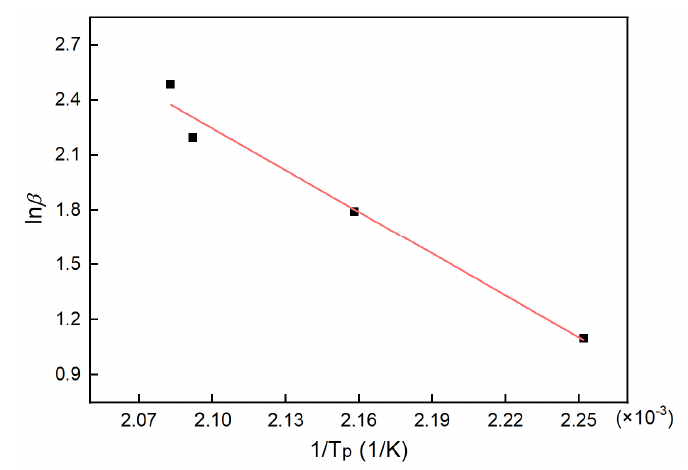
Figure 4. The fitting line according to the Crane equation. Table 2. DSC data based on Figure 5.